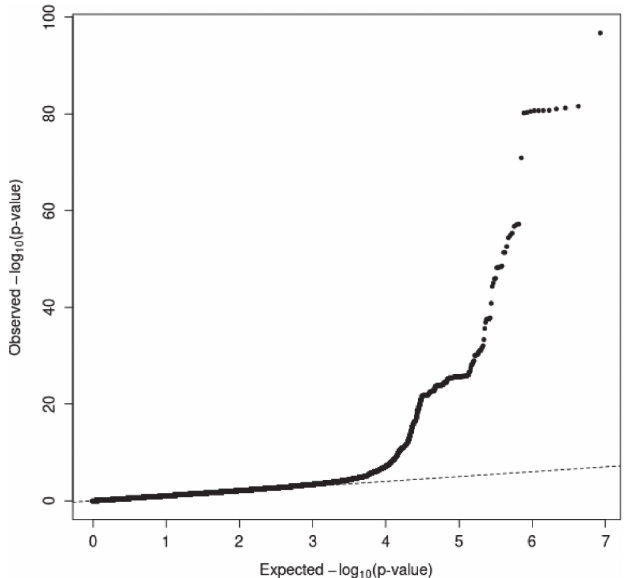
Figure 1. Q-Q plot for P values from original GWAS data. The vertical and horizontal axes indicate observed and expected % log 10 ( P value) for tests of associa- tion between SNPs and HDL-C, respectively. GWAS, genome-wide association study; HDL-C, high-density lipoprotein cholesterol; SNP, single- nucleotide